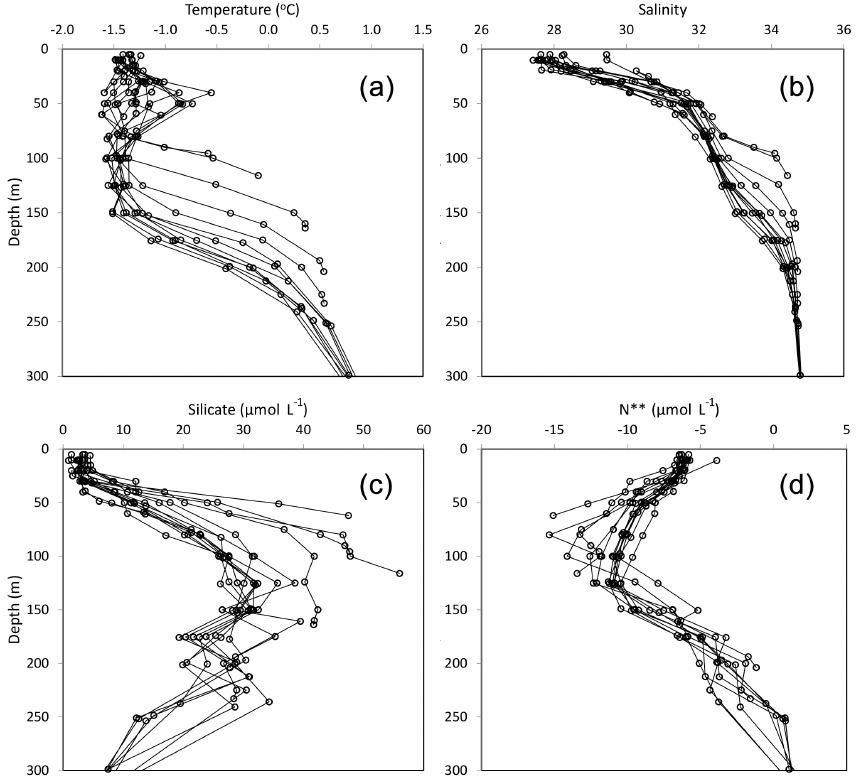
Figure 7. Depth profiles of temperature (a) , salinity (b) , silicate (c) , and N ∗∗ (d) in the upper 300m of all stations at sections D and E; see Fig. 1 for